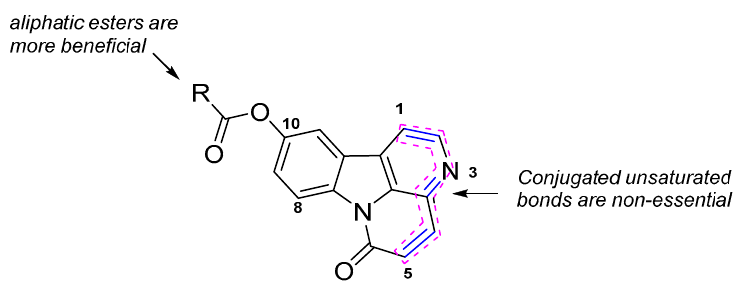
Figure 2. Structure-activity relationship for the antifungal activity.